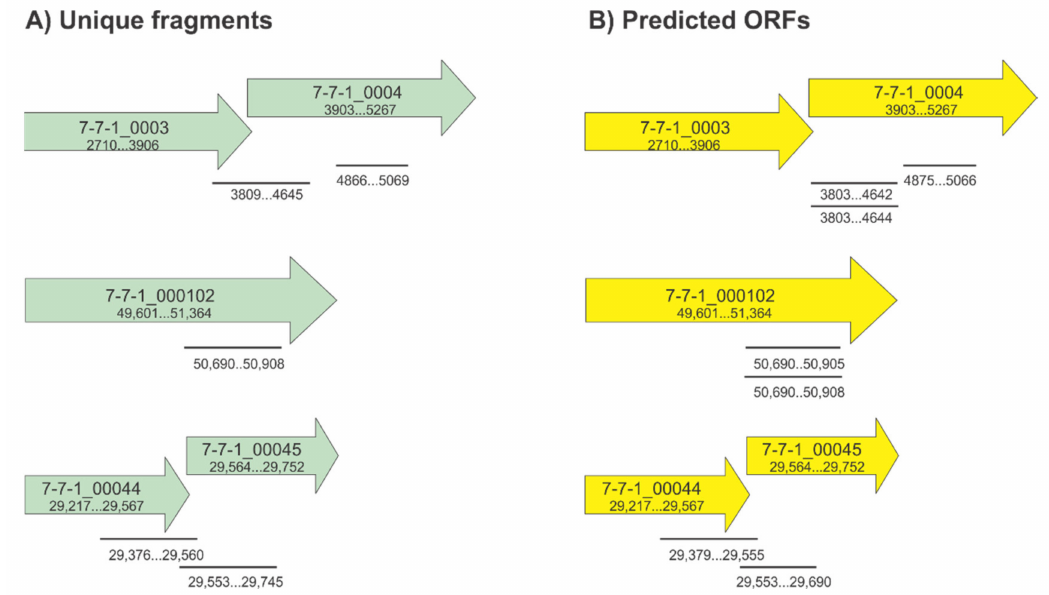
Figure 2. Fragment mapping to phage 7-7-1 genome. ( A ) illustration of unique fragments in reference to the genome and ( B ) predicted ORFs as determined by the SnapGene software.